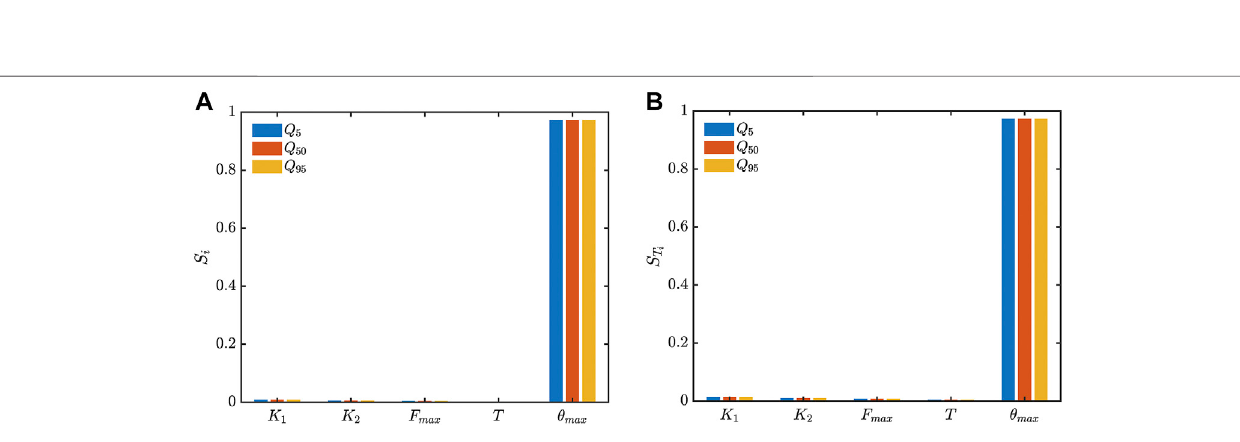
Frontiers in Built Environment |